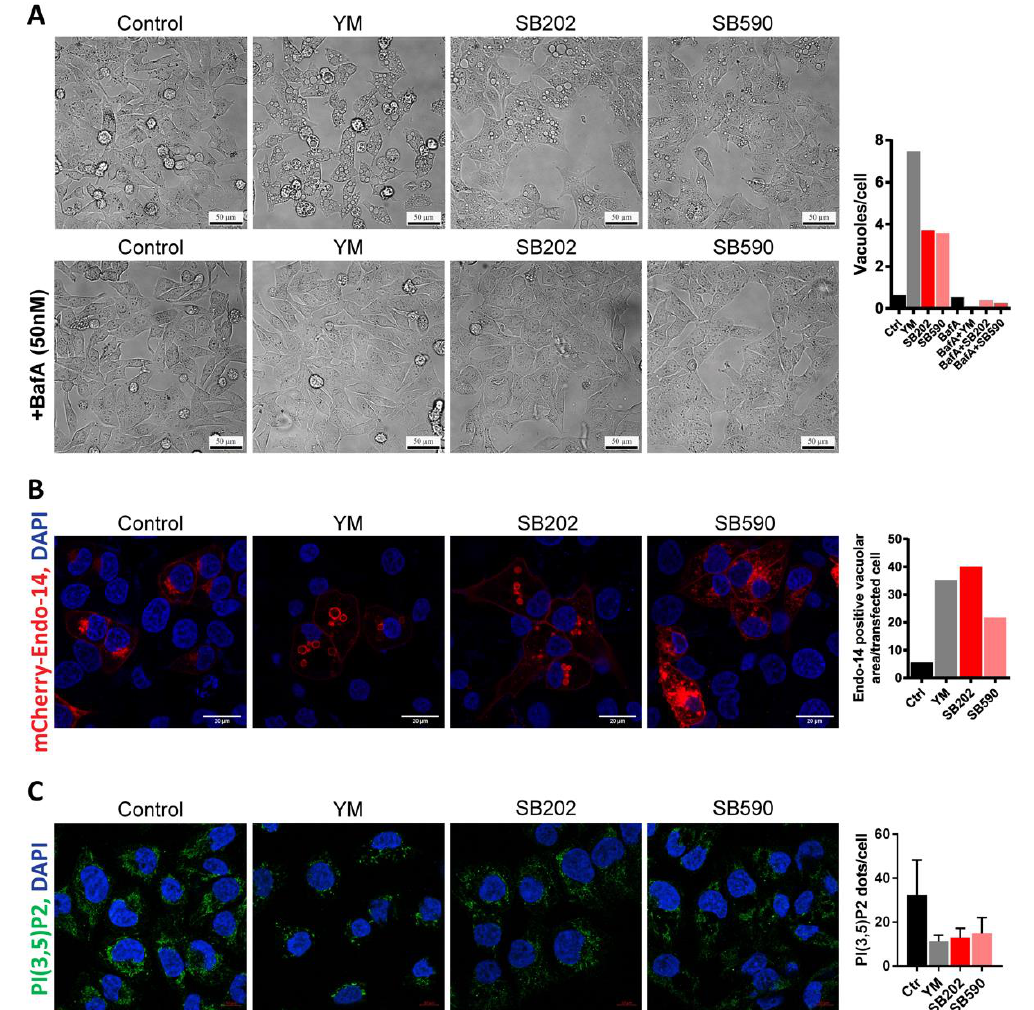
Figure 4. Phenotype induced in melanoma cells by pyridinyl imidazole compounds partly mimics PIKfyve inhibition. A375 cells were treated 24 h with pyridinyl imidazole inhibitors SB202190 (SB202; 15 µ M),SB590885(SB590; 5 µ M),andPIKfyveinhibitorYM201636(YM;1 µ M).( A )Aphase-contrastanalysis of the vacuolization induced by the inhibitors and the e ff ect of the cotreatment with bafilomycin A (BafA; 50 nM). Scale bar: 50 µ m. Vacuoles per cell were quantified using ImageJ / Fiji (find maxima—bright spots above a certain threshold) and presented in the graph. Dying rounded cells were excluded from the analysis. Three independent experiments showed a similar e ff ect of the addition of BafA. ( B ) Confocal microscopy analysis of fluorescent protein-labeled endosomal marker (mCherry-Endo-14). Scale bar: 20 µ m. The area of mCherry-positive vacuolar structures was quantified in each treatment and plotted in the graph. Three independent experiments showed similar results. ( C ) Confocal fluorescence microscopy detection of endogenous phosphatidylinositol 3,5-bisphosphate (PI(3,5)P2). Scale bar: 10 µ m. Three images of di ff erent parts of the same specimen were acquired and analyzed using ImageJ / Fiji. Images were thresholded by the signal intensity, and the amount of PI(3,5)P2 foci per cell was determined. Similar results were obtained in two independent